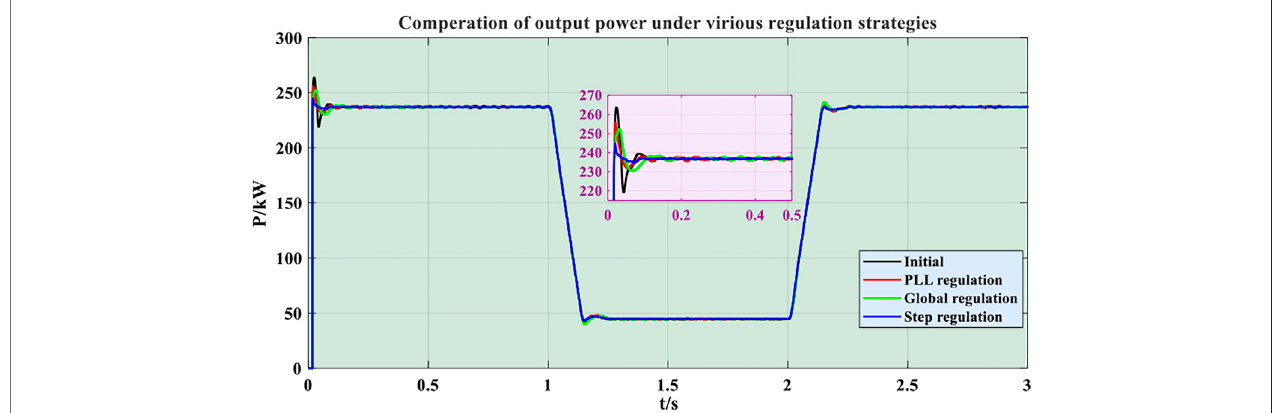
FIGURE 5 | Comparison results of output power responding curves under different regulation strategies.